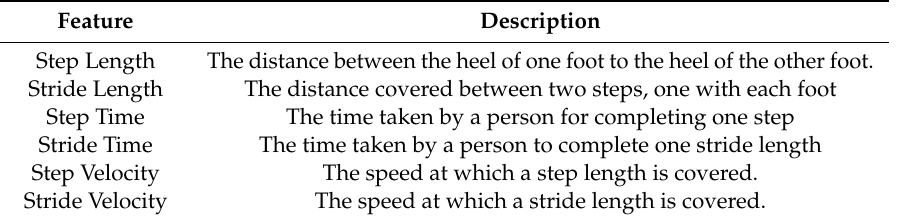
Table 4. Gait Parameter Based Feature.